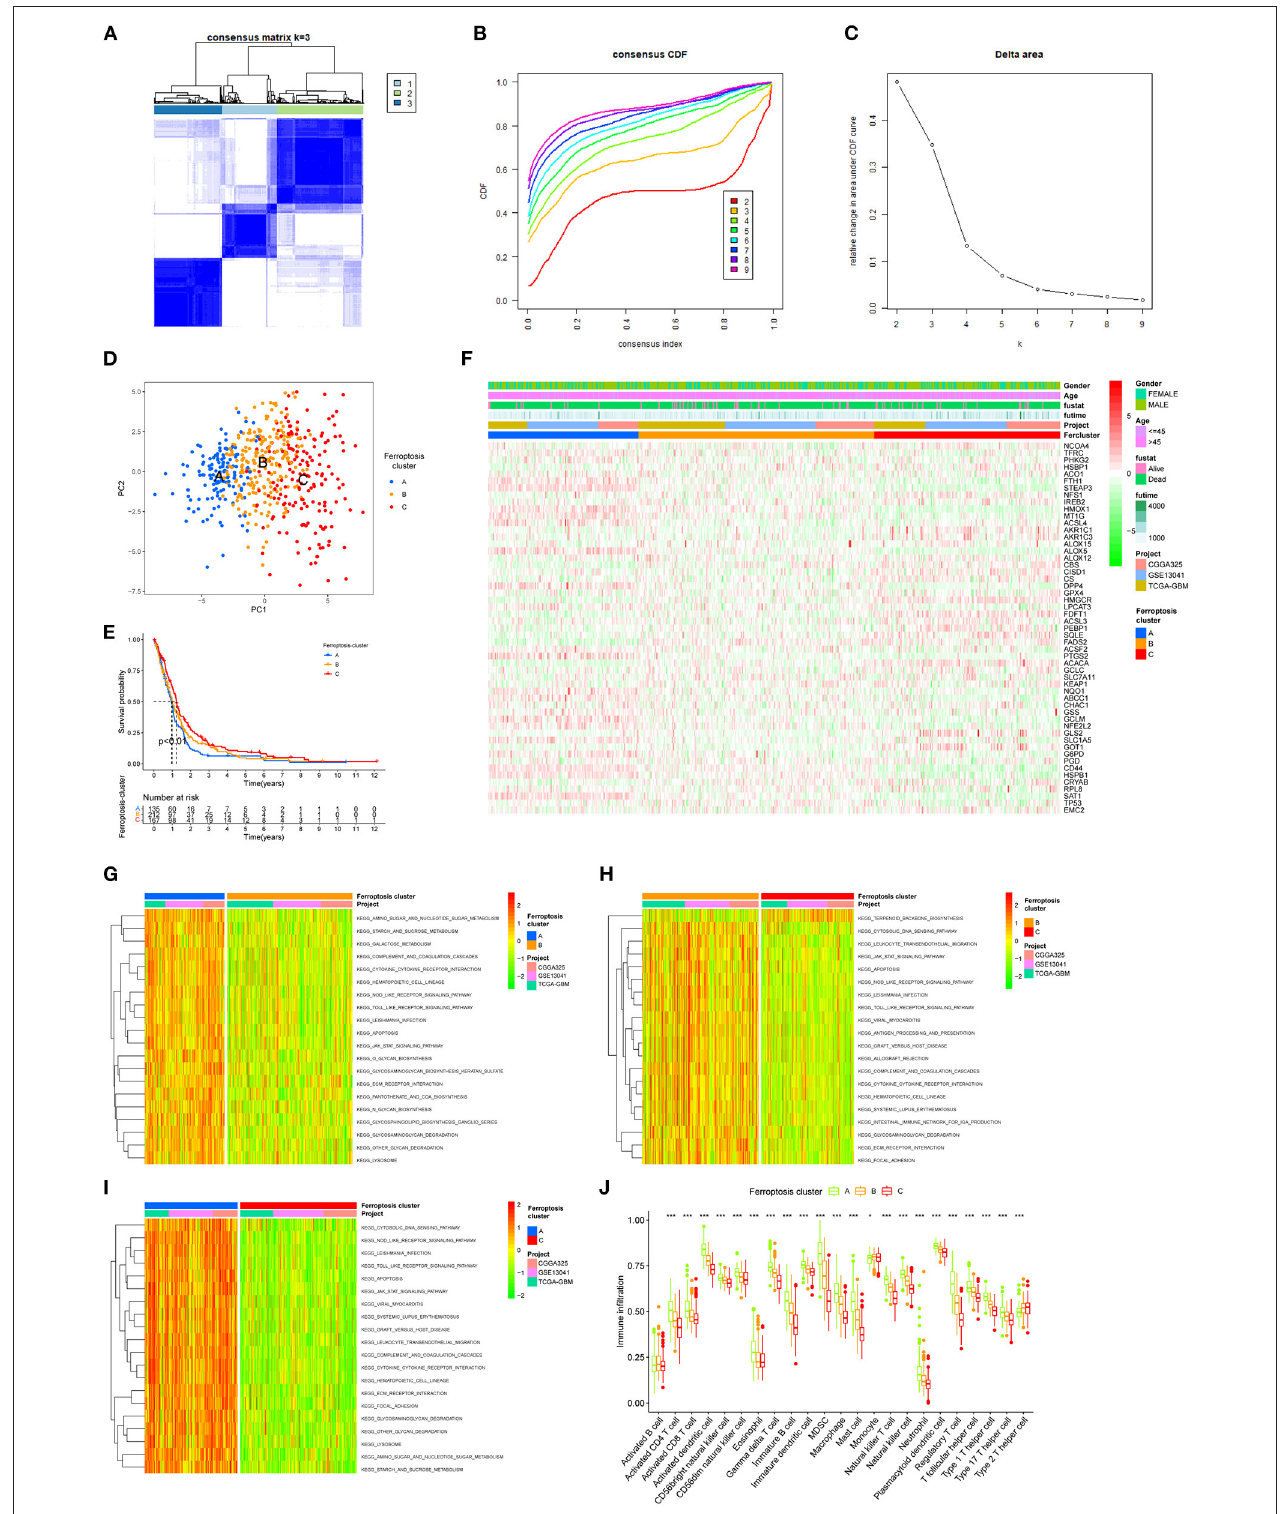
FIGURE 3 | The unsupervised clustering process for FRGs. (A) Consensus clustering matrix for k = 3. (B) Consensus clustering CDF for k = 2–9. (C) Relative change in area under the CDF curve for k = 2–9. (D) A PCA plot of unsupervised clustering when k = 3. (E) Prognostic differences between the three clusters after merging survival information ( p < 0.01). (F) The heatmap of three clusters and their clinical characteristics. (G–I) Visualization for the results of KEGG for DEGs with three clusters. (J) The relative enrichment of each immune cell fraction in the TIME with the gene sets using ssGSEA (* p < 0.05, ** p < 0.01, *** p < 0.001).